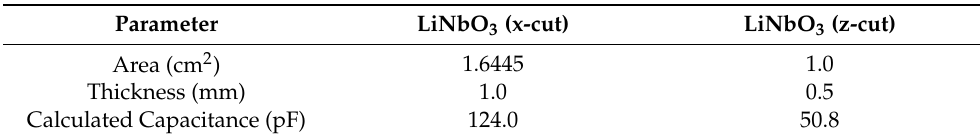
Table 3. Expectation values for the capacitance measurements of x-cut and z-cut lithium niobate (LiNbO 3 ) single crystal samples.